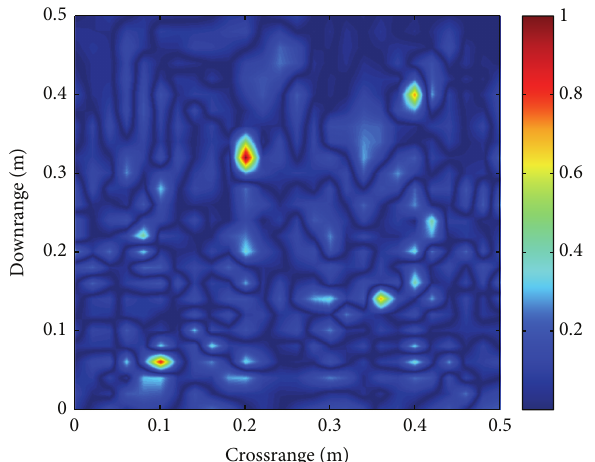
Figure 5: Imaging result obtained by using the proposed